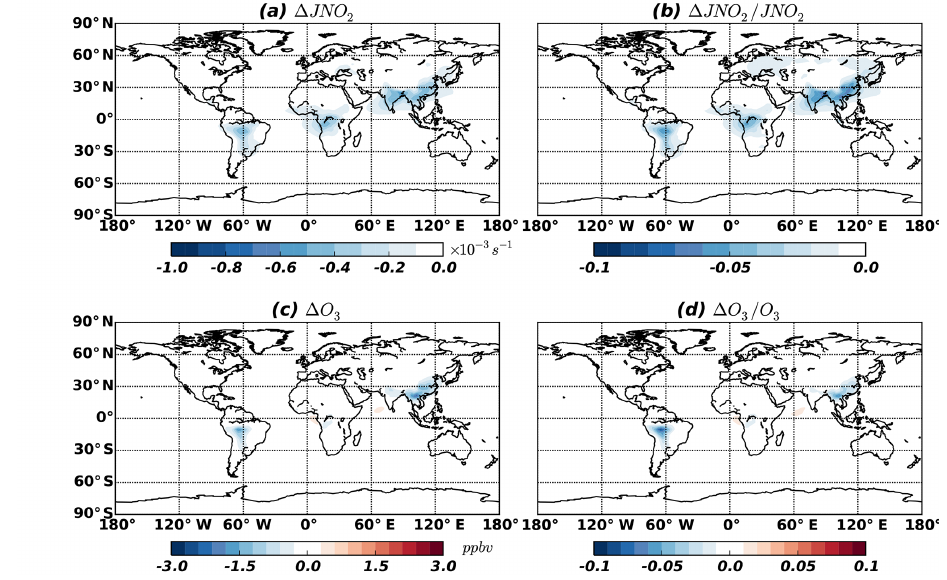
Figure 9. Changes in annual NO 2 photolysis rate (a, b) and O 3 concentration (c, d) at the surface due to BrC